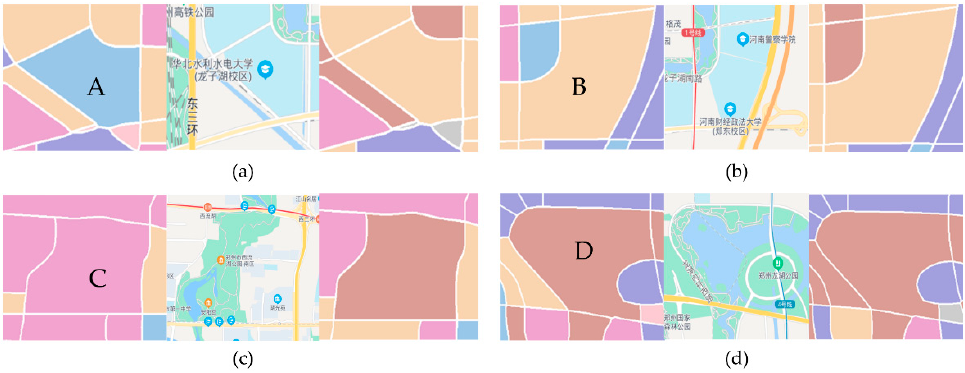
Figure 16. Comparison of partial identification results of GloVe with the actual function types and Baidu map: ( a ) area A of Figure 12b; ( b ) area B of Figure 12b; ( c ) area C of Figure 12b; ( d ) area D of Figure 12b.